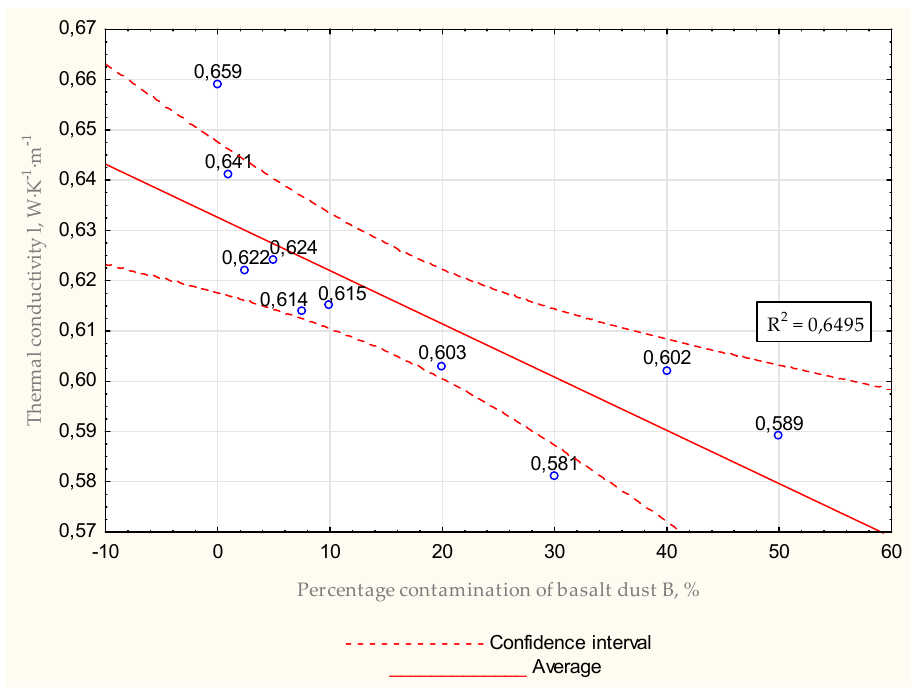
Figure 14. Average thermal conductivity for basalt dust B for water − mix ratio = 0.7.